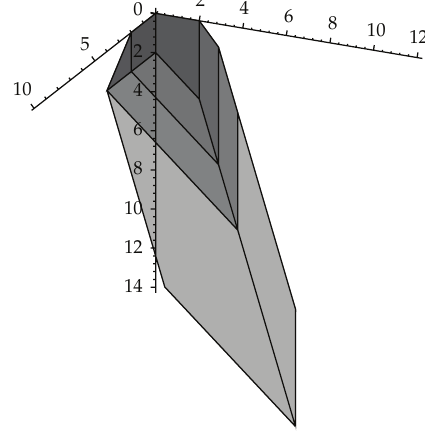
Figure 3: An example of the polytope P 3 in the case r (cid:7)